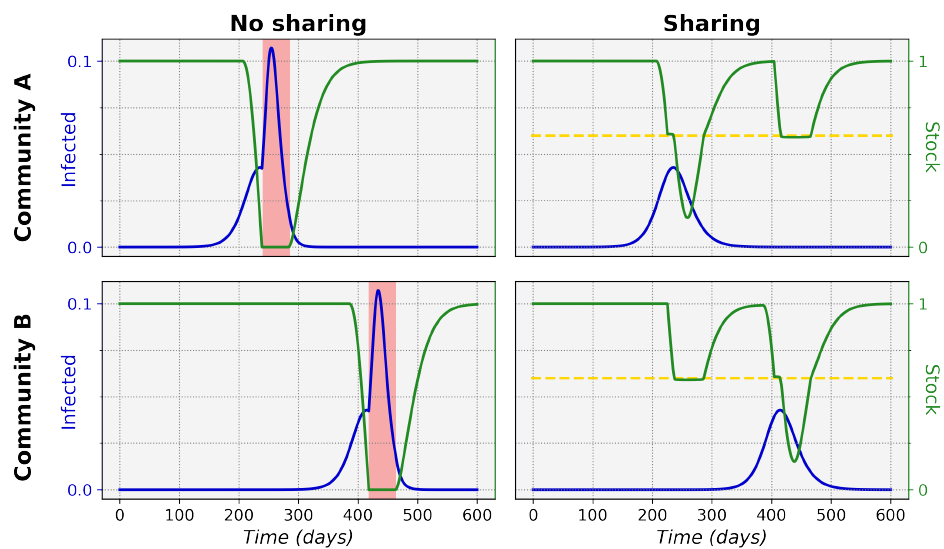
Figure 1. Time evolution of epidemic development in two communities without and with sharing mechanism. Shown are the proportions of infected (blue) relative to the total community population and the proportions of stock (green) relative to the maximum stock over time. The communities had an equal maximum stock of S max = 3 × 10 7 . The only difference between the communities was epidemic onset, with epidemic introduction in A at t = 0 and in B at t = ∆ t = 180 days. Critical zero-stock periods are shaded in red in the no-sharing condition (left column). The lack of stock leads to an increase in epidemic spread and a high infected peak. The sharing threshold θ = 0.6 (yellow dotted line) is indicated in the sharing condition (right column). Here, sharing prevents the total depletion of stock and the associated high infected peak: both the local and total infected ratios are low. n = 1.7 × 10 7 , R 0 = 2.3, γ = 1/6, r = 0.4, w = 4, P ( 0 ) = 5 × 10 7 , P max = 4 × P ( 0 ) , D ( 0 ) = P ( 0 )